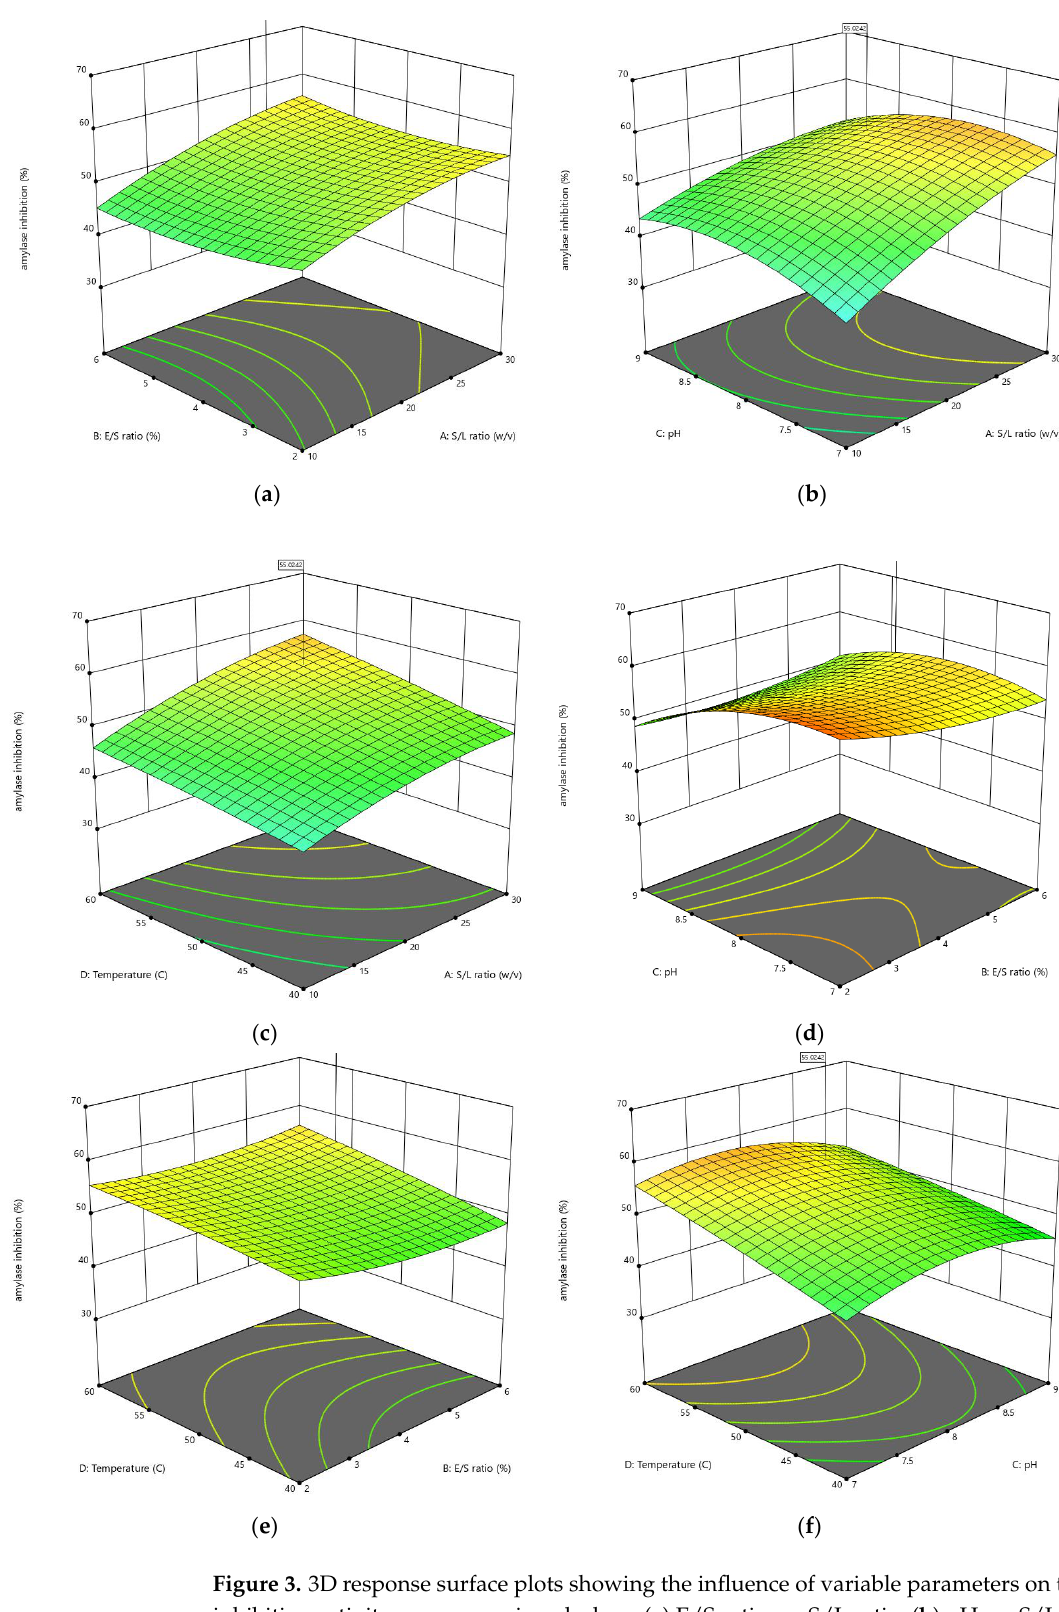
Figure 3. 3D response surface plots showing the influence of variable parameters on the α -amylase inhibition activity response using alcalase: ( a ) E/S ratio vs. S/L ratio, ( b ) pH vs. S/L ratio, ( c ) tem- perature vs. S/L ratio, ( d ) pH vs. E/S ratio, ( e ) temperature vs. S/L ratio and ( f ) temperature vs. pH.